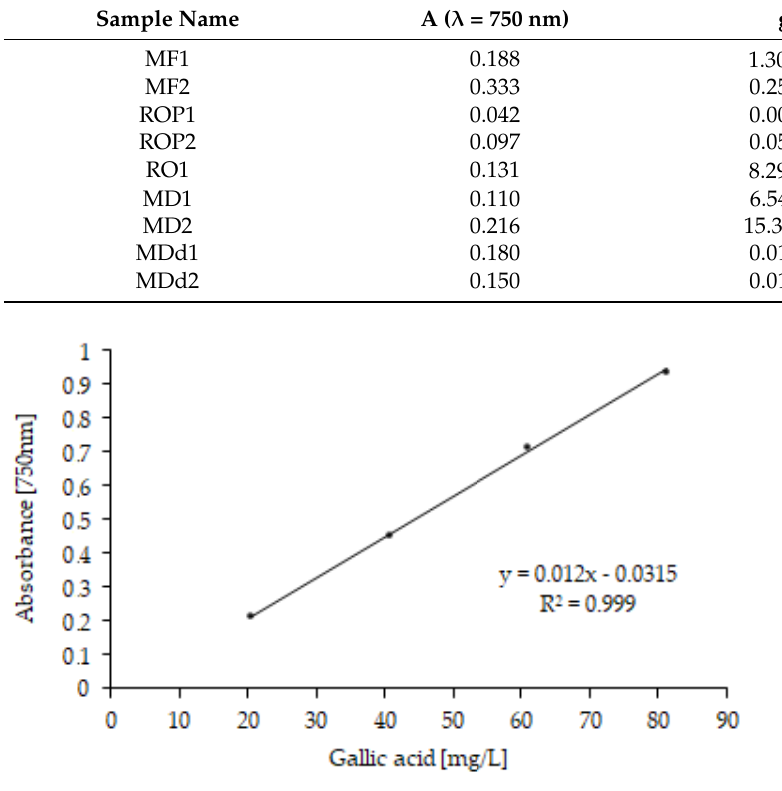
Figure 6. Gallic acid calibration curve (concentrations ranging from 20 to 80